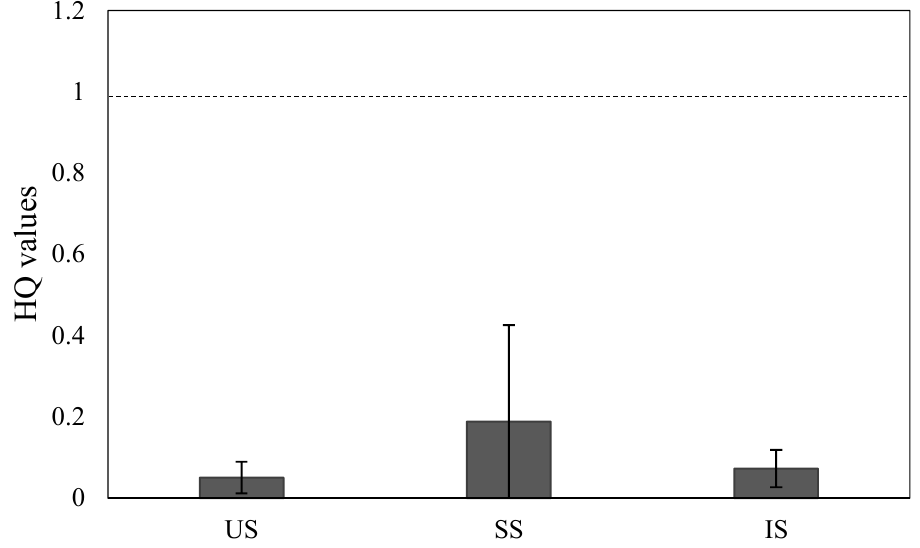
Figure 6. Average Hazard Quotient (HQ) of PHg at urban (US), suburban (SS) and industrial (IS) sites. The dotted line shows the acceptable limit of HQ i.e., 1 as established by US EPA.